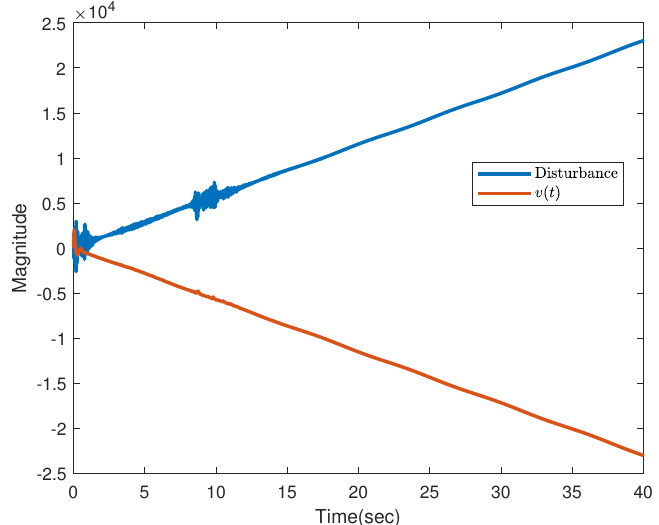
Figure 11. Time history of the compensator control input (22) v ( t ) , based on the estimates produced by the observer (16), against the disturbance ξ ( t ) = K 5 u q = 4024.14 ( 0.1 t + 0.001cos ( 10 t )) , in the presence of a white noise with diffusion v 0.75 2